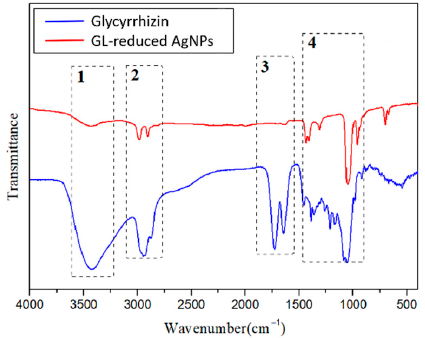
Figure 6. FT-IR spectra of glycyrrhizin-reduced AgNPs and glycyrrhizin.